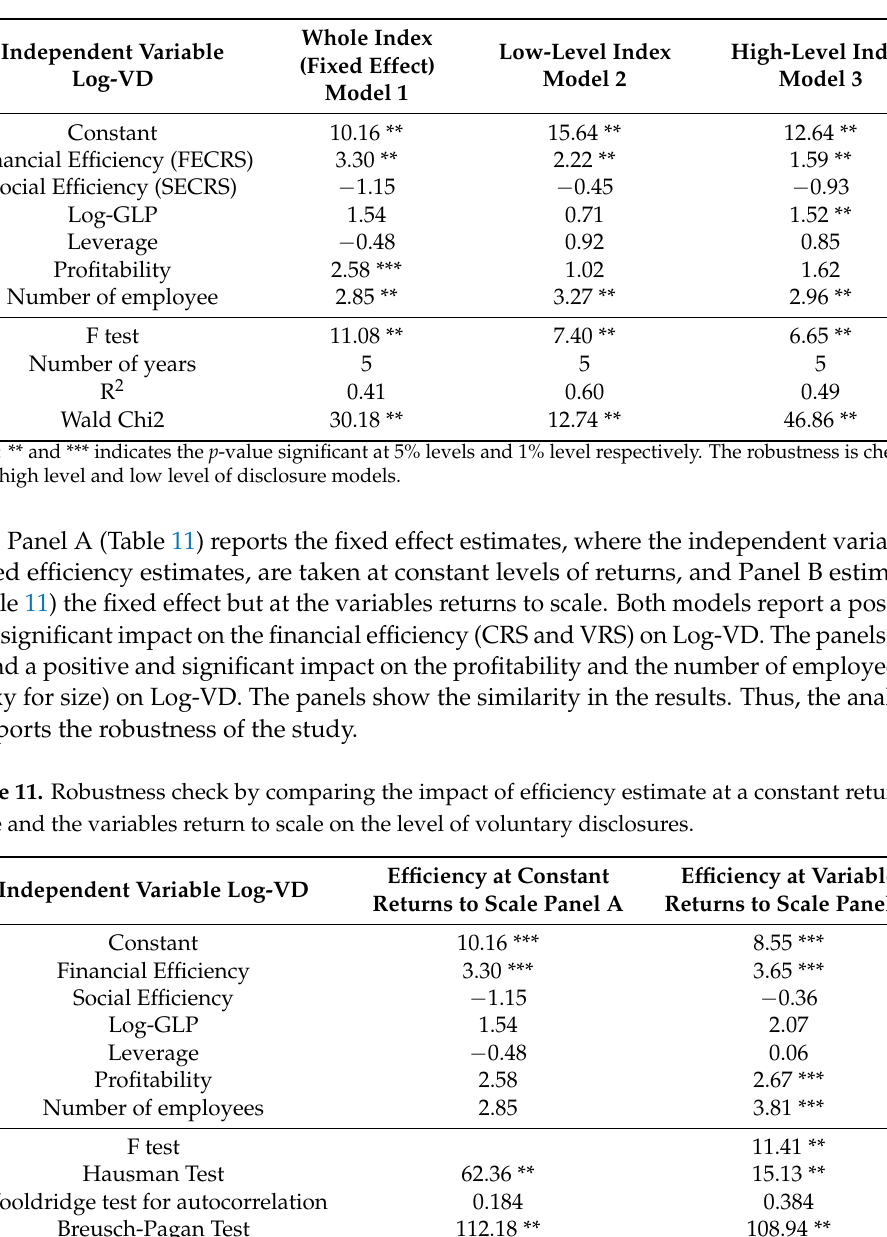
Table 10. Robustness check with a lower and higher level of disclosures.